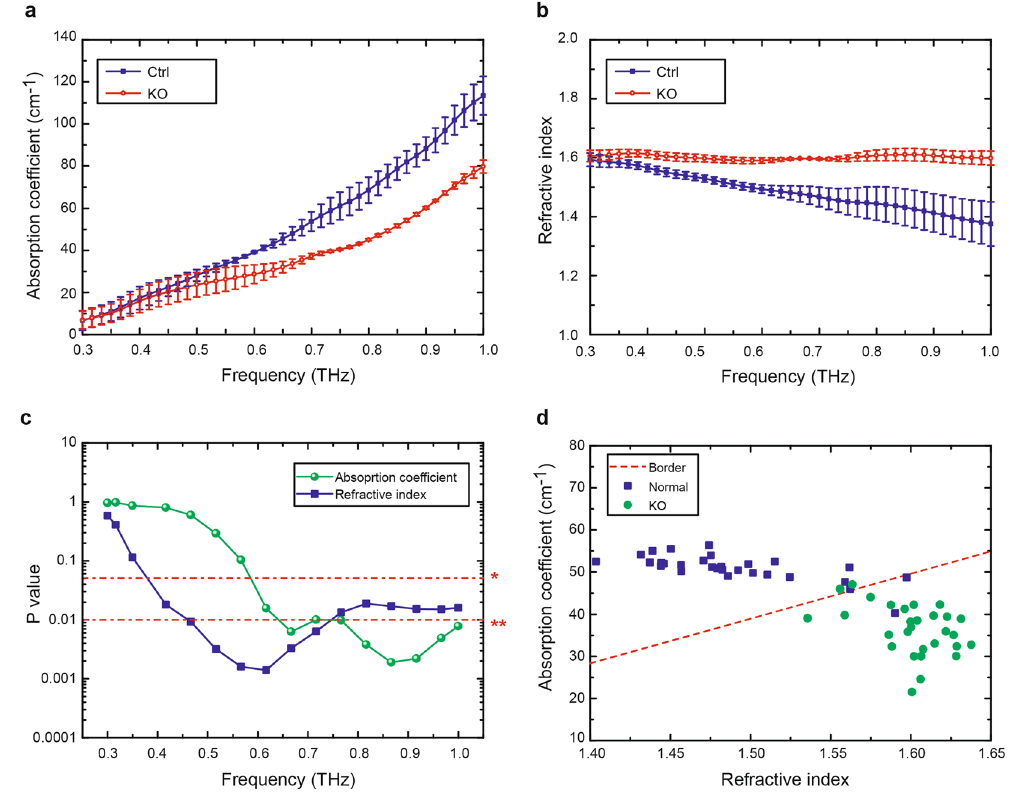
Figure 2. THz properties of myelin deficit brain from Rheb1 KO mice in the frequency range from 0.3 to 1.0 THz. ( a ) Absorption coefficient of the paraffin-embedded brain samples from normal (blue solid square, Ctrl) and Rheb1 KO (red empty circle, KO). ( b ) Refractive index of paraffin-embedded brain samples from normal and Rheb1 KO. ( c ) P-value of absorption coefficient (green circular dot) and refractive index (blue square) results. * p < 0.05, ** p < 0.01. ( d ) Score plot of the values for refractive index and absorption coefficient obtain from Rheb1 KO (green circular dots) and normal (blue square) brains.